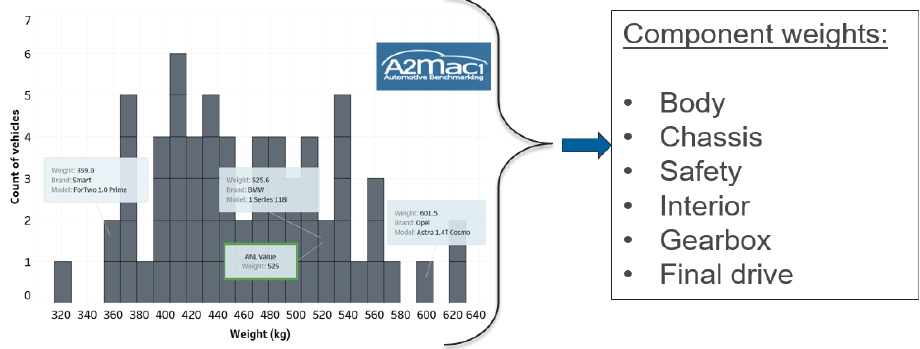
Figure 4. Vehicle component weight selection for different vehicle configurations.